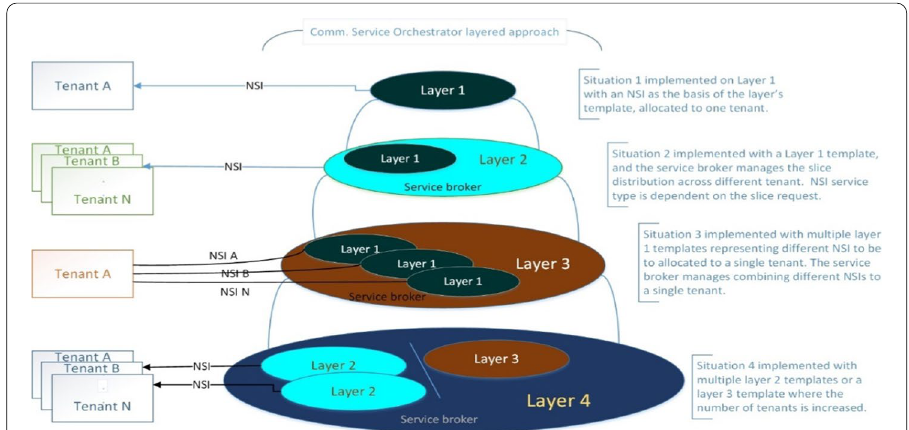
Fig. 10 Communication service orchestrator implementation of multitenant‑slice situation types. The figure presents the layers approach for achieving communication service distribution for each possible situation types that can